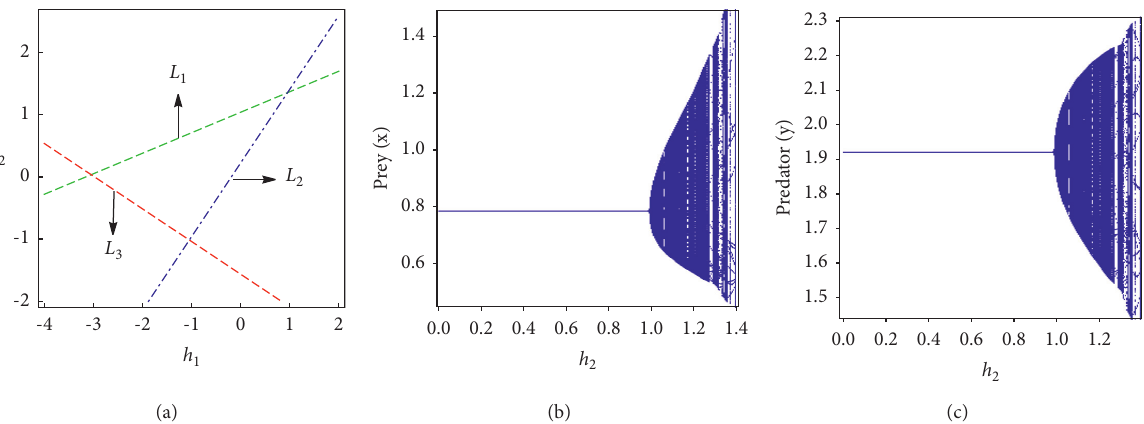
Figure 7: For the controlled system (36) with r E ∗ ( x ∗ ,y ∗ ) � ( 0 . 787379 , 1 . 922151 ) . (a) The stability triangle and ((b), (c) the bifurcation diagrams with h